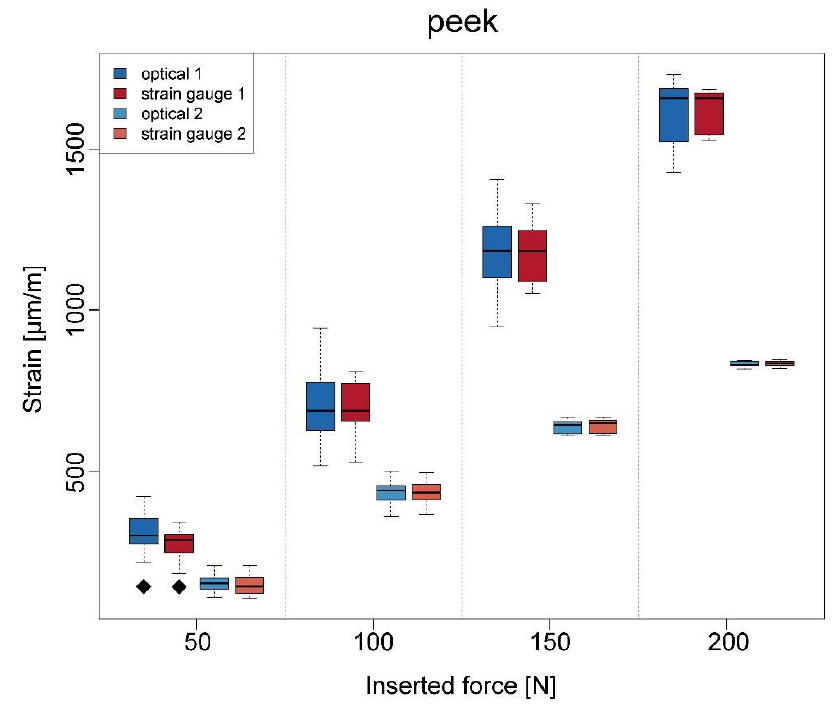
Figure 6. Boxplots regarding the strain at different inserted forces and in the case of the superstructure made of